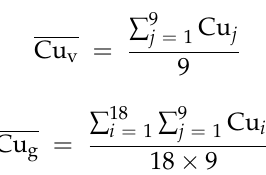
For tangential and radial directions, nine different local means, Cu 18 images acquired at the same X, Y-position on the platform over 18 layers. In the vertical, 18 local (cid:3364)(cid:3364)(cid:3364)(cid:3364)(cid:3364) , are calculated, each from nine images of a layer. Global mean, Cu means, Cu v